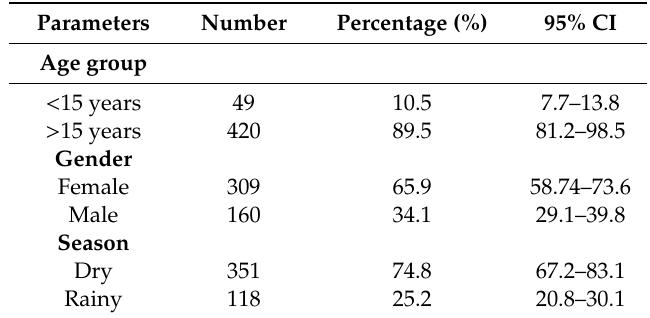
Table 1. Socio-demographic characteristics of the study population ( n =